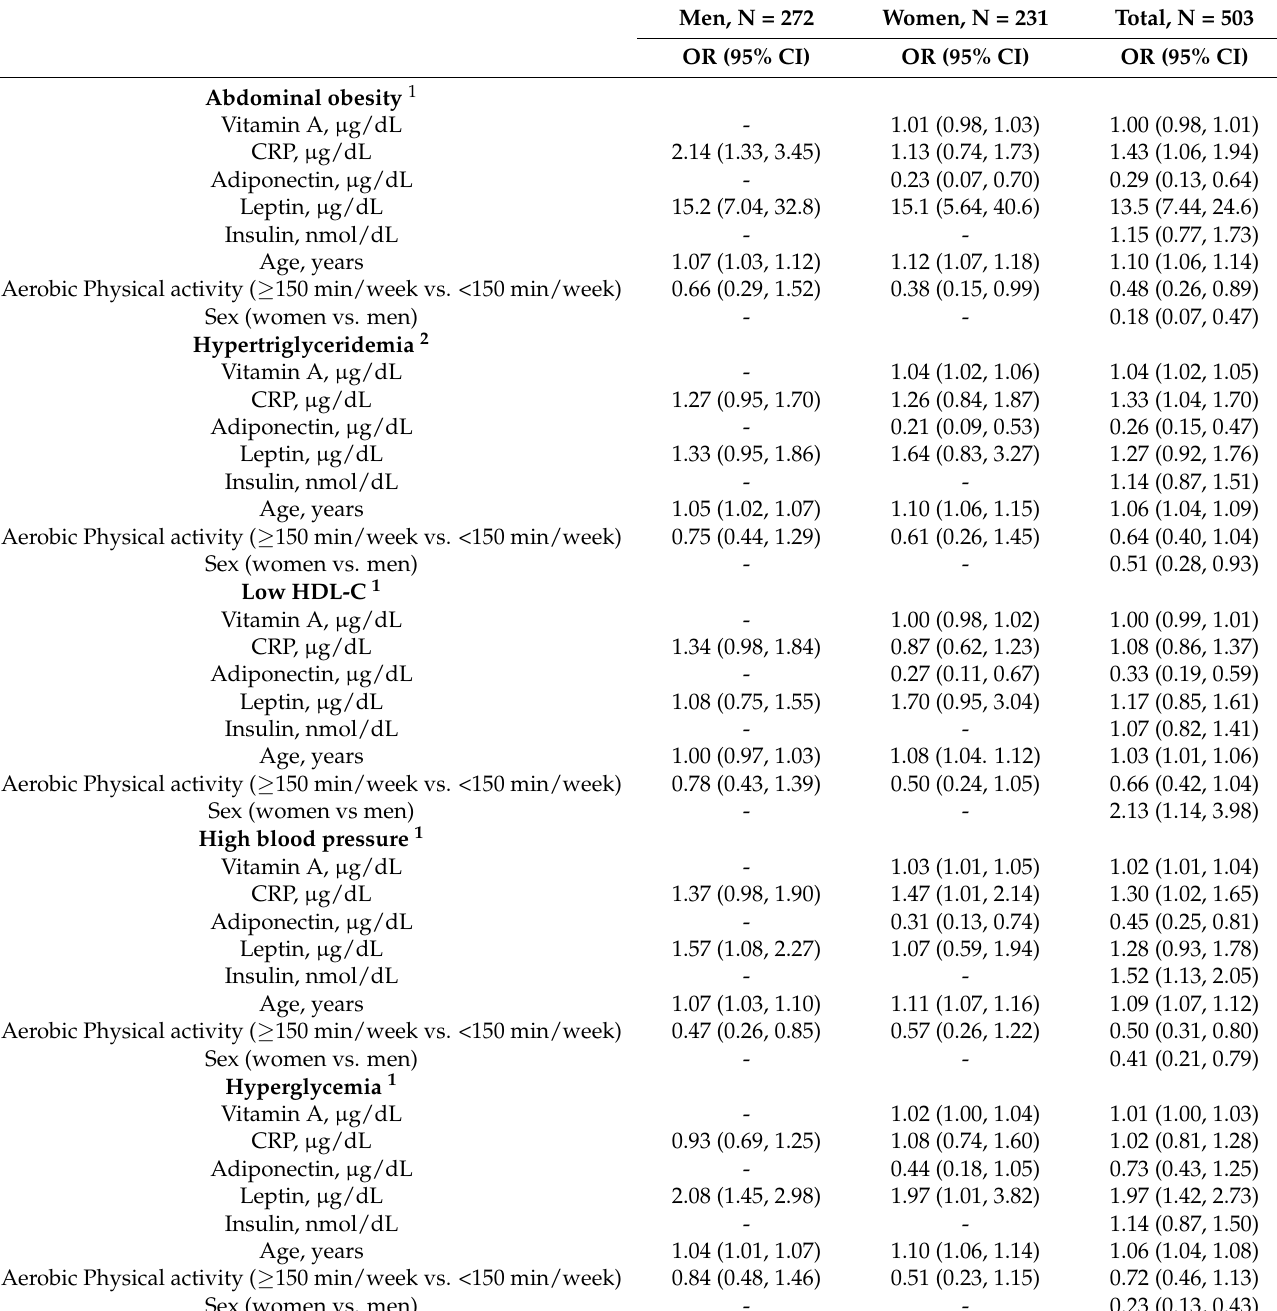
Table 4. Variables selected by the LASSO logistic regression, measuring the association between metabolic syndrome components and micronutrients and markers of inflammation and oxidative stress (N =